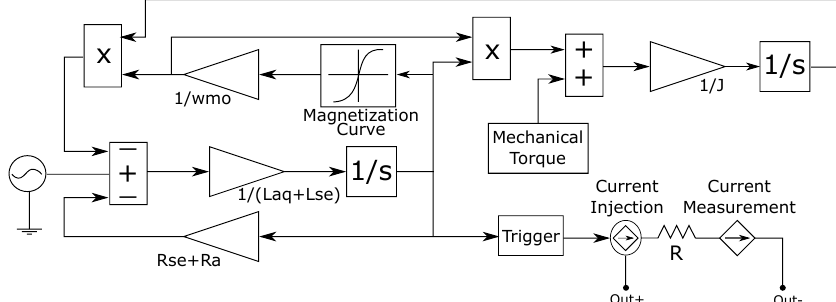
Figure 7. MATLAB-Simulink block diagram of Universal Motor Model.